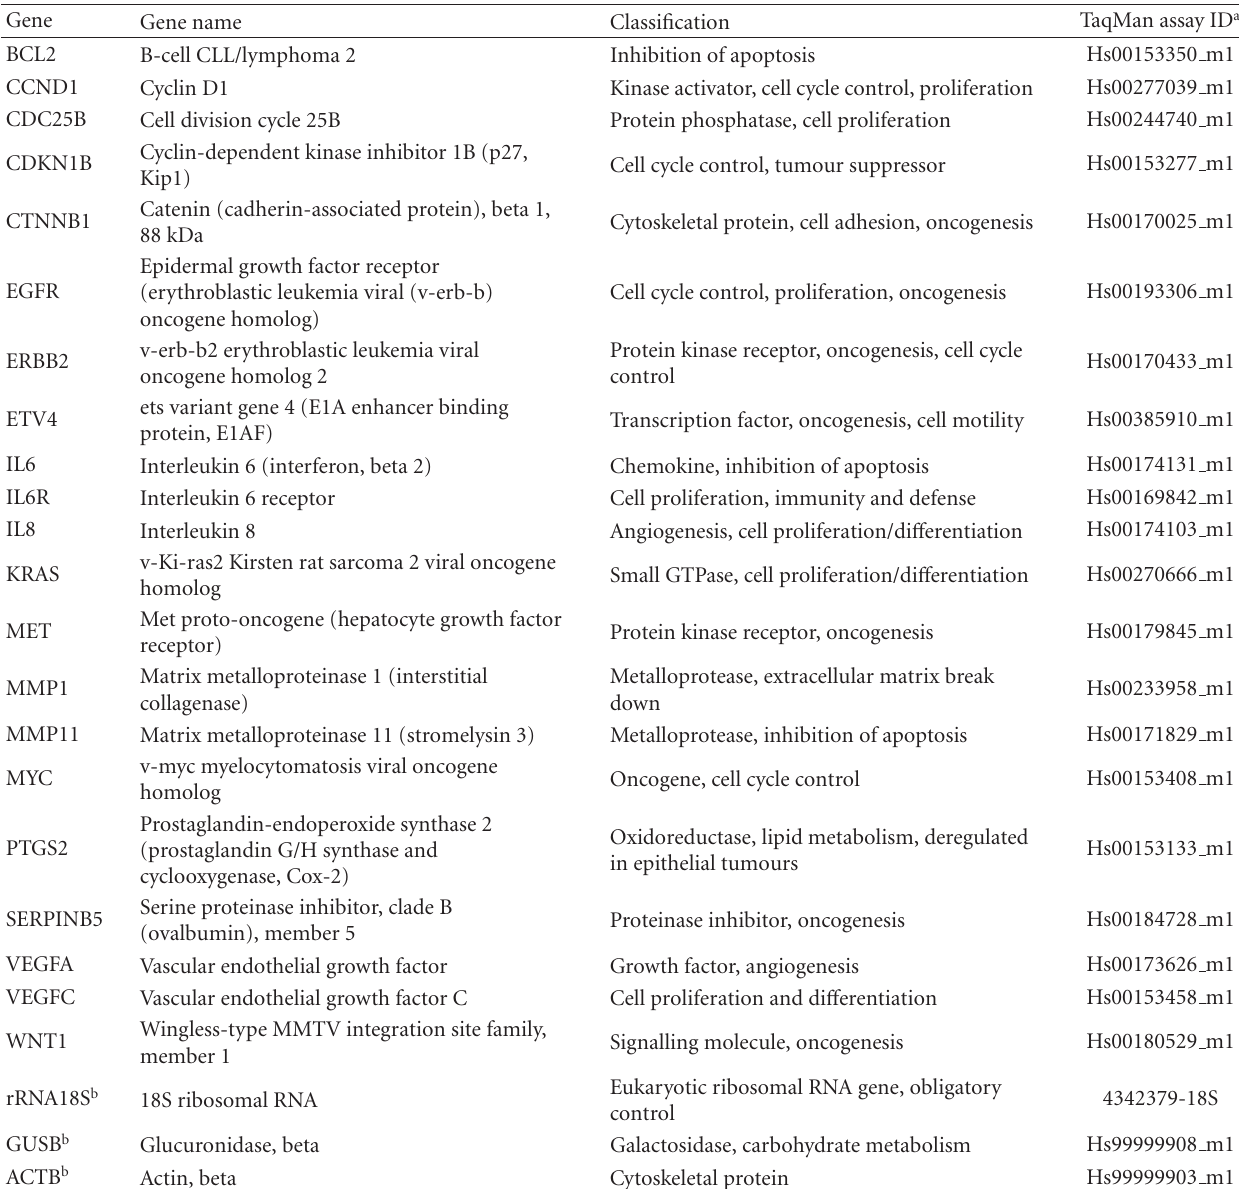
Table 1: Sequences amplified on TaqMan low density